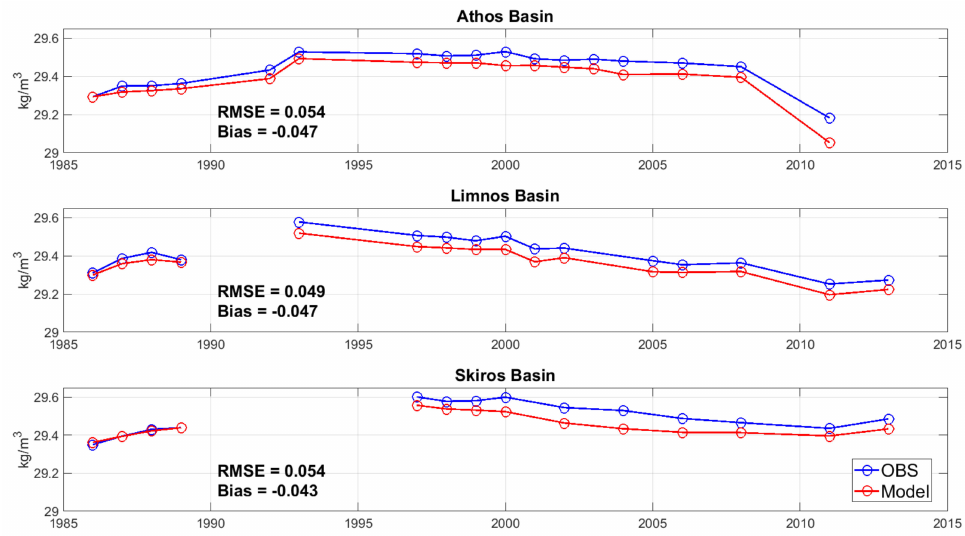
Figure 15. North Aegean deep basins potential density ( σ θ 0 ) interannual evolution vertically inte- grated from 600 m to maximum depth for the period from 1986 to 2013. The red line refers to model results and the blue line to observations.